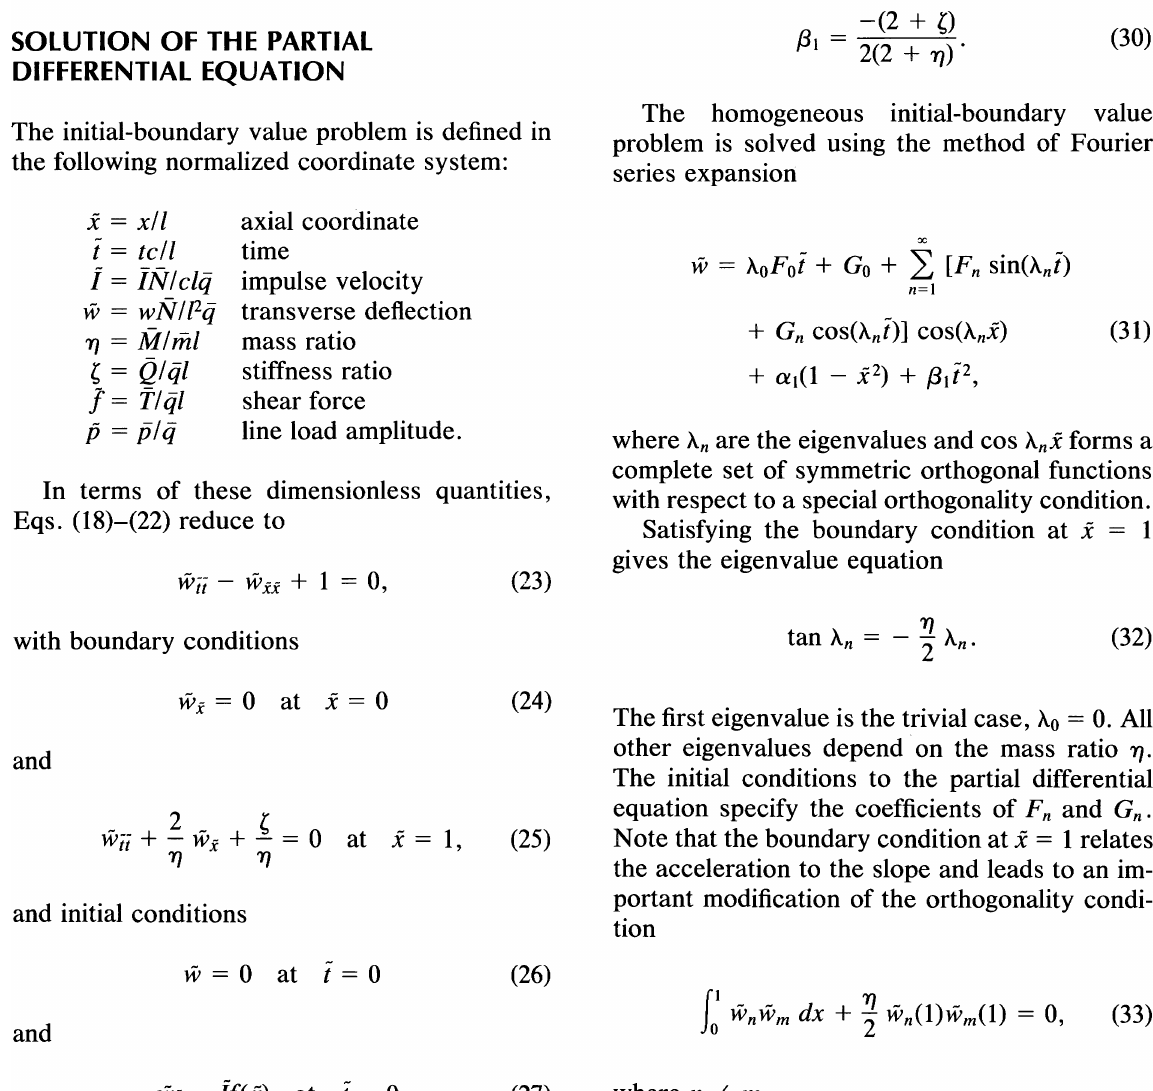
FIGURE 3 A continuous-discrete model of a single bay in the ring-stiffened